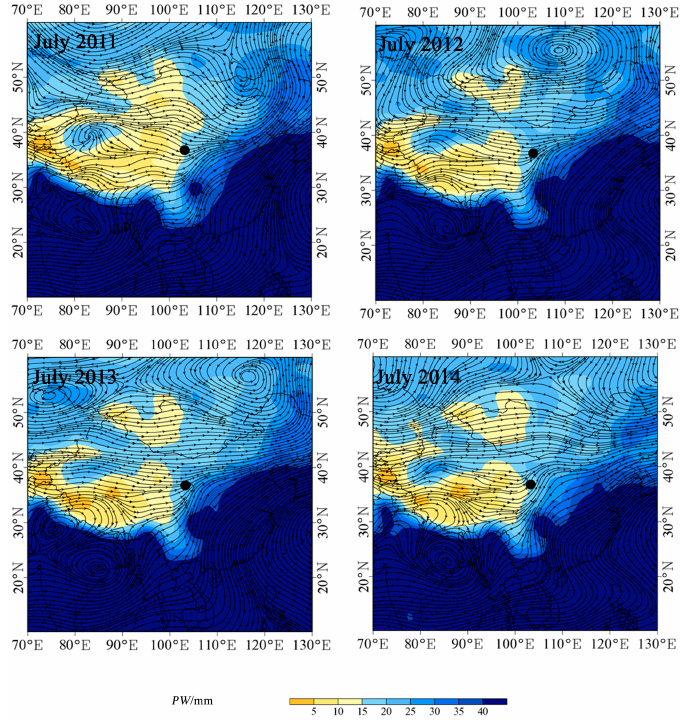
Figure 8. Water vapor stream and precipitable water amount ( PW ) surrounding the study region in July for different years.